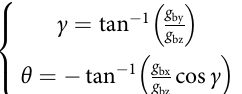
shown in Fig. 3, where P ð k þ 1 Þ k is the state vector prediction error, P k is the error of the fi lter output in the k th iteration, K k þ 1 is the fi lter gain.